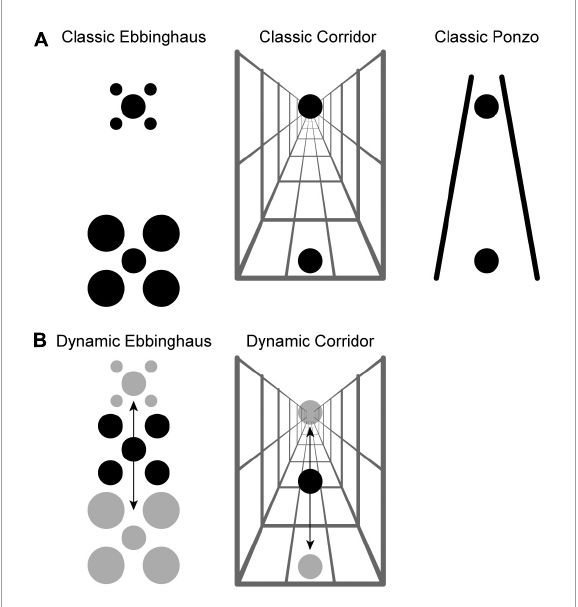
FIGURE1 (A) Classic visual size illusions: Ebbinghaus, Corridor, and Ponzo. In all panels, the center black circles are all the same physical size. The surrounding context in each panel is such that the perceived size of the bottom black circle tends to be less than the perceived size of the top black circle. (B) Dynamic variants of the Ebbinghaus and Corridor illusion akin to those studied by Mruczek et al. (2020). The black arrow indicates the direction of motion of the stimulus. For the Dynamic Ebbinghaus, the entire stimulus (target and inducers) translated, and the inducers fluctuated between small and large. For the Dynamic Corridor, the target translated along a stationary corridor